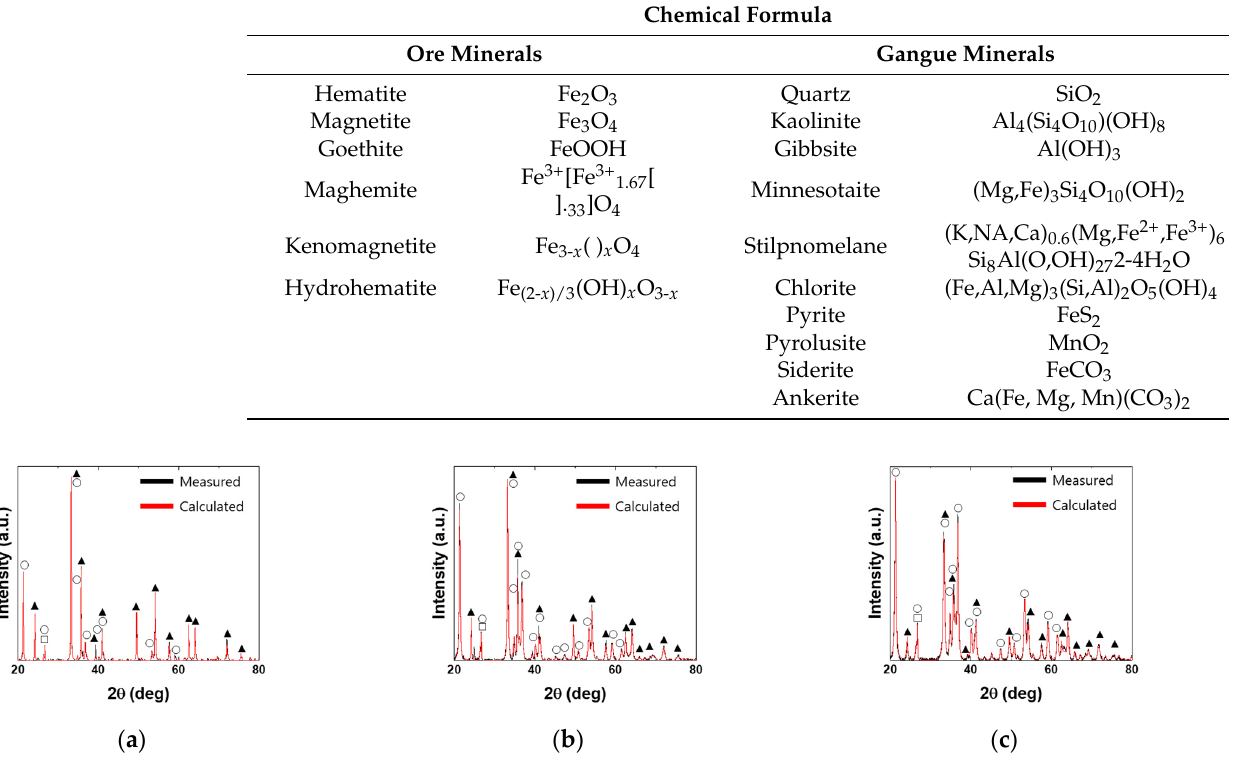
Figure 2. X-ray diffraction patterns and Rietveld analysis results: ( a ) Carajás ore, ( b ) Yandi ore, and ( c ) Mining Area C ore ( ▲ : Hematite; ○ : Goethite; □ : Quartz). Table 3. Common ore minerals and gangue mineral phases in iron ore [4]. Table 4. Phase fractions of iron ores determined through Rietveld analysis